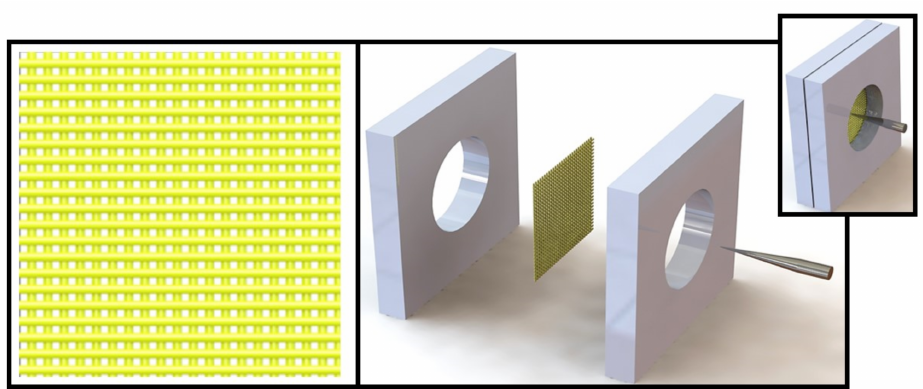
Figure 12. Illustration of geometrical puncture simulation